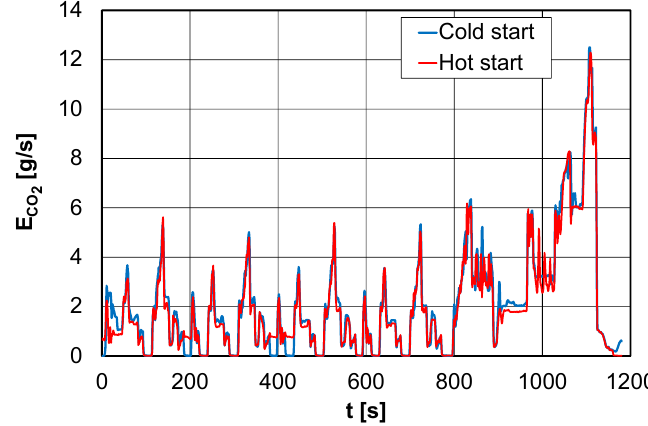
Figure 7. Carbon dioxide exhaust emissions (E CO2 ) for cold and hot engine start.